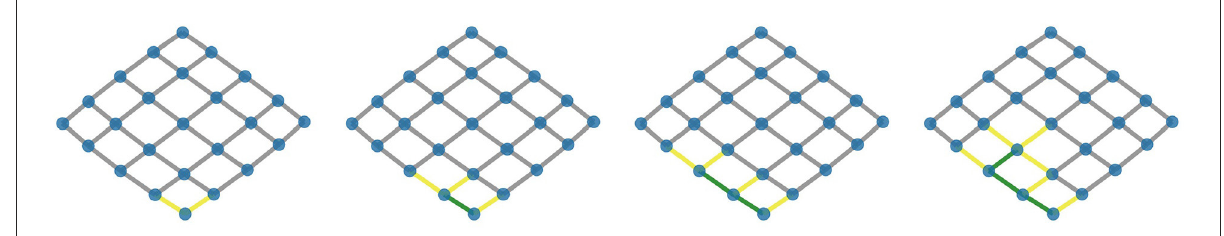
FIGURE3 Trajectory-based cascading spread model illustration (yellow: infected edge; green: travel path).